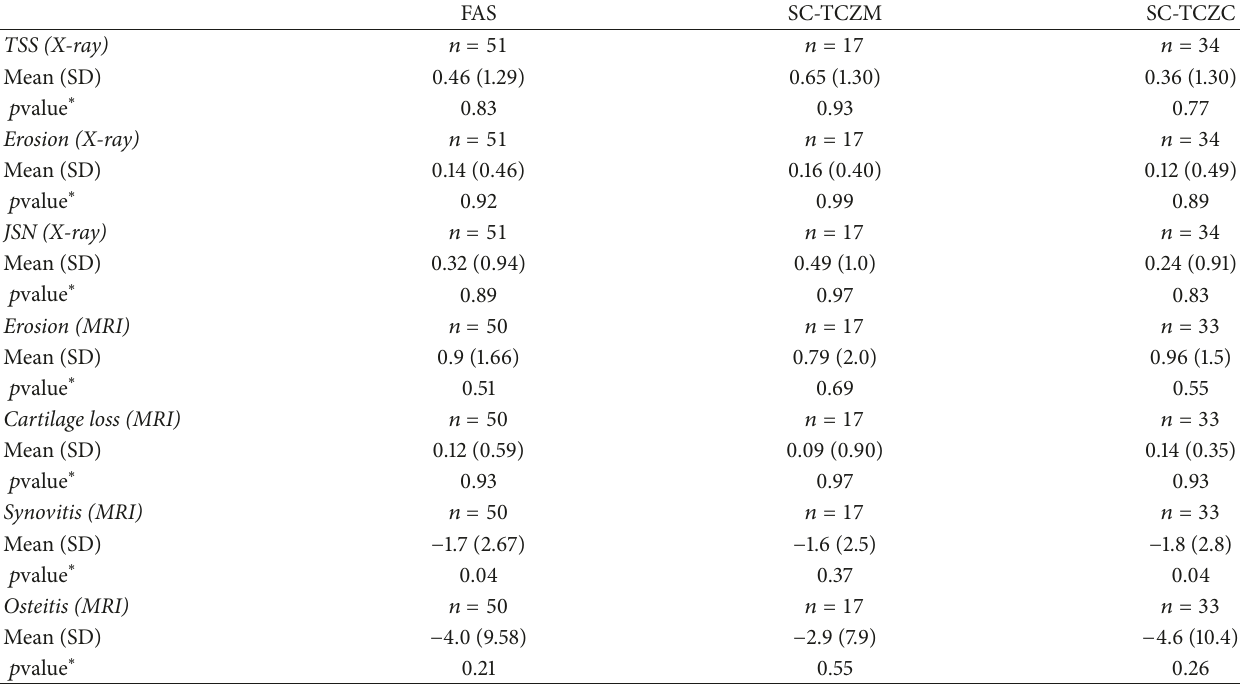
Table 2: Changes in TSS and components and RAMRIS feature scores from baseline to Week